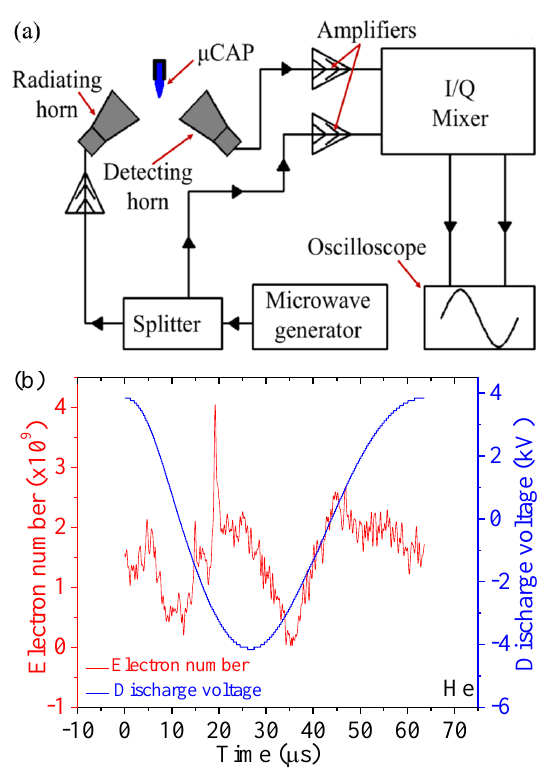
Figure 2. Schematics of the Rayleigh microwave scattering (RMS) experimental setup ( a ), as well as the electron number and discharge voltage of He ( b ). He: Helium